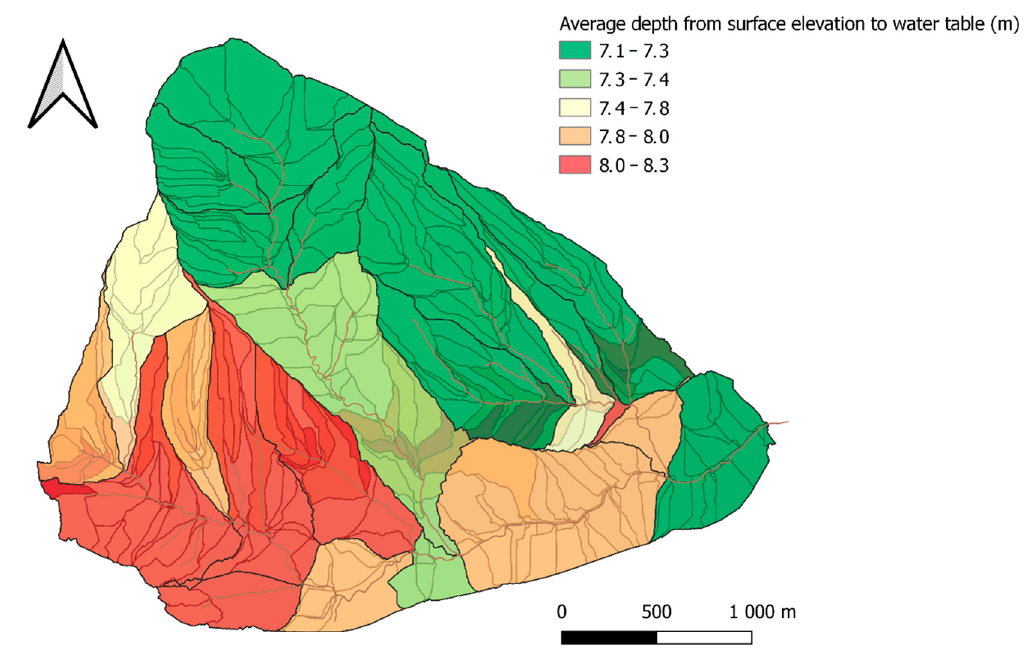
Figure 9. Distance from surface to water table for Smugawka catchment.